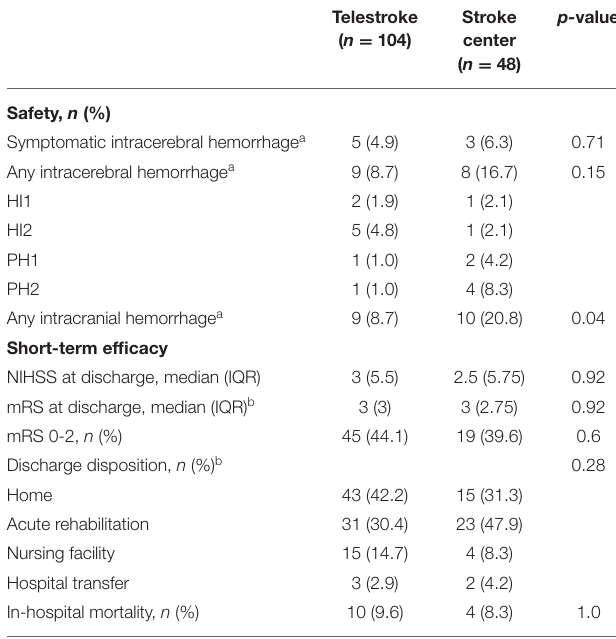
TABLE 2 | Safety and short-term efficacy